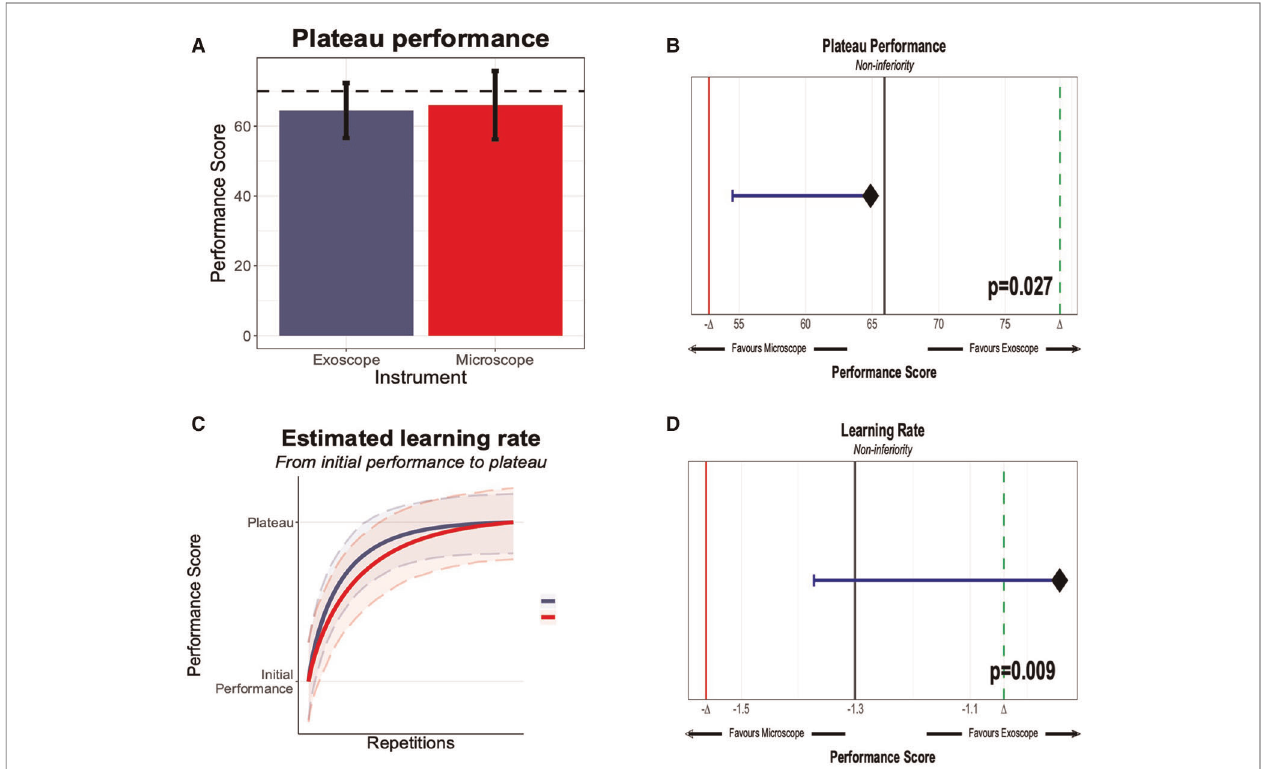
FIGURE 3 | ( A ) Plateau performance between the novices, starting the “ Star ’ s the limit ” task on the exoscope or the microscope. The performance score was 0 – 100, generated through methods outlined in section Methods, with an expert threshold score of 70. ( B ) Signi fi cant noninferiority of the microscope and exoscope based on novice performance compared against the expert performance. ( C ) Learning rate of novices on the exoscope or the microscope. ( D ) Learning rate and statistical noninferiority of the exoscope compared to the